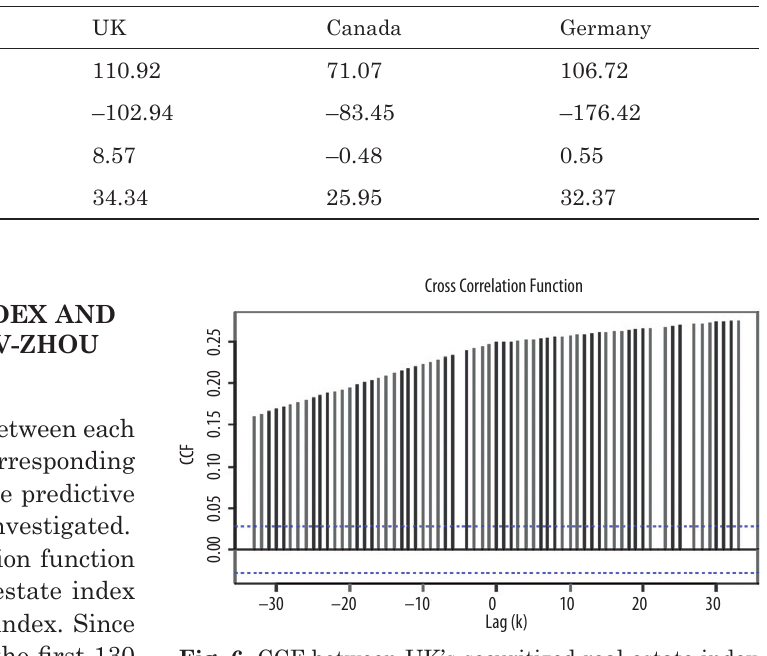
Fig. 6. CCF between UK’s securitized real estate index and its corresponding Shiryaev-Zhou index